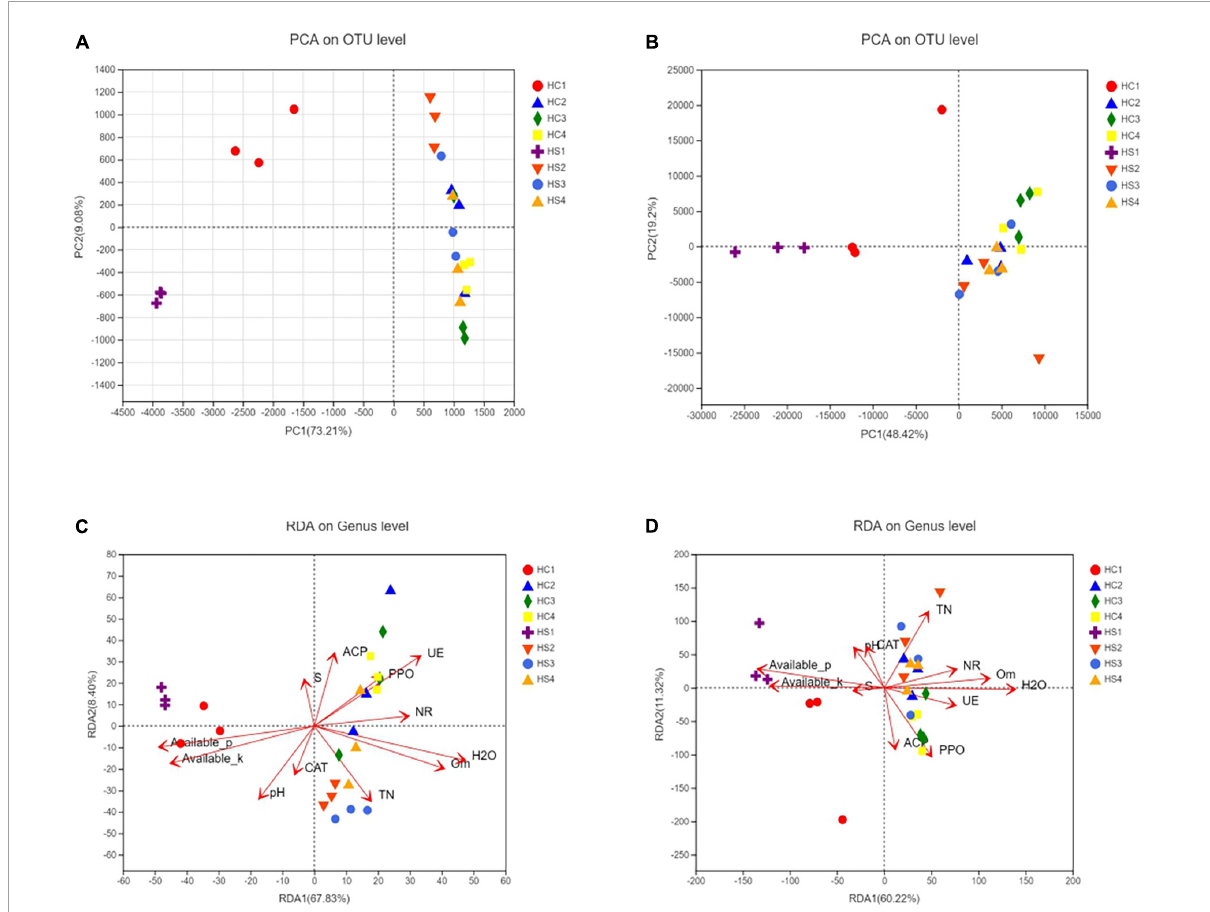
FIGURE5 Principal component analysis (PCA) analysis of bacterial and fungal (A,B) communities in a β -diversity analysis of tobacco soil microbial community; RDA analysis between bacterial or fungal community and environmental factors, respectively (C,D)